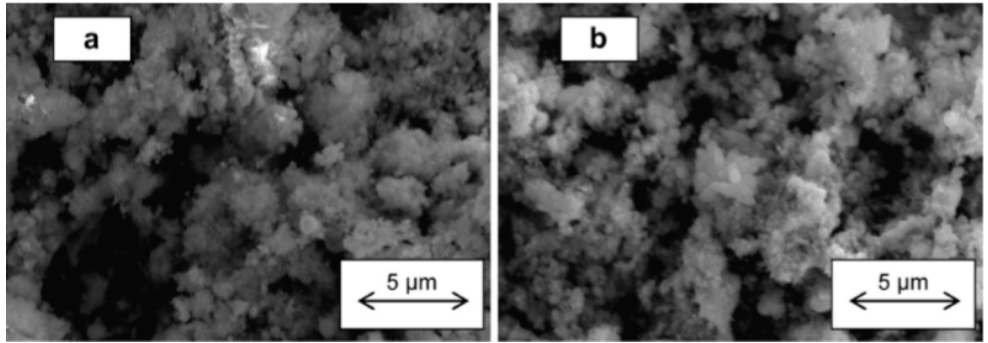
Figure 15. Surface morphologies of Ni-SDC cermet coatings using ( a ) SP1 and ( b ) SP2. Reproduced with permission from [45], ELECTROCHEMICAL SOCIETY, 2011.